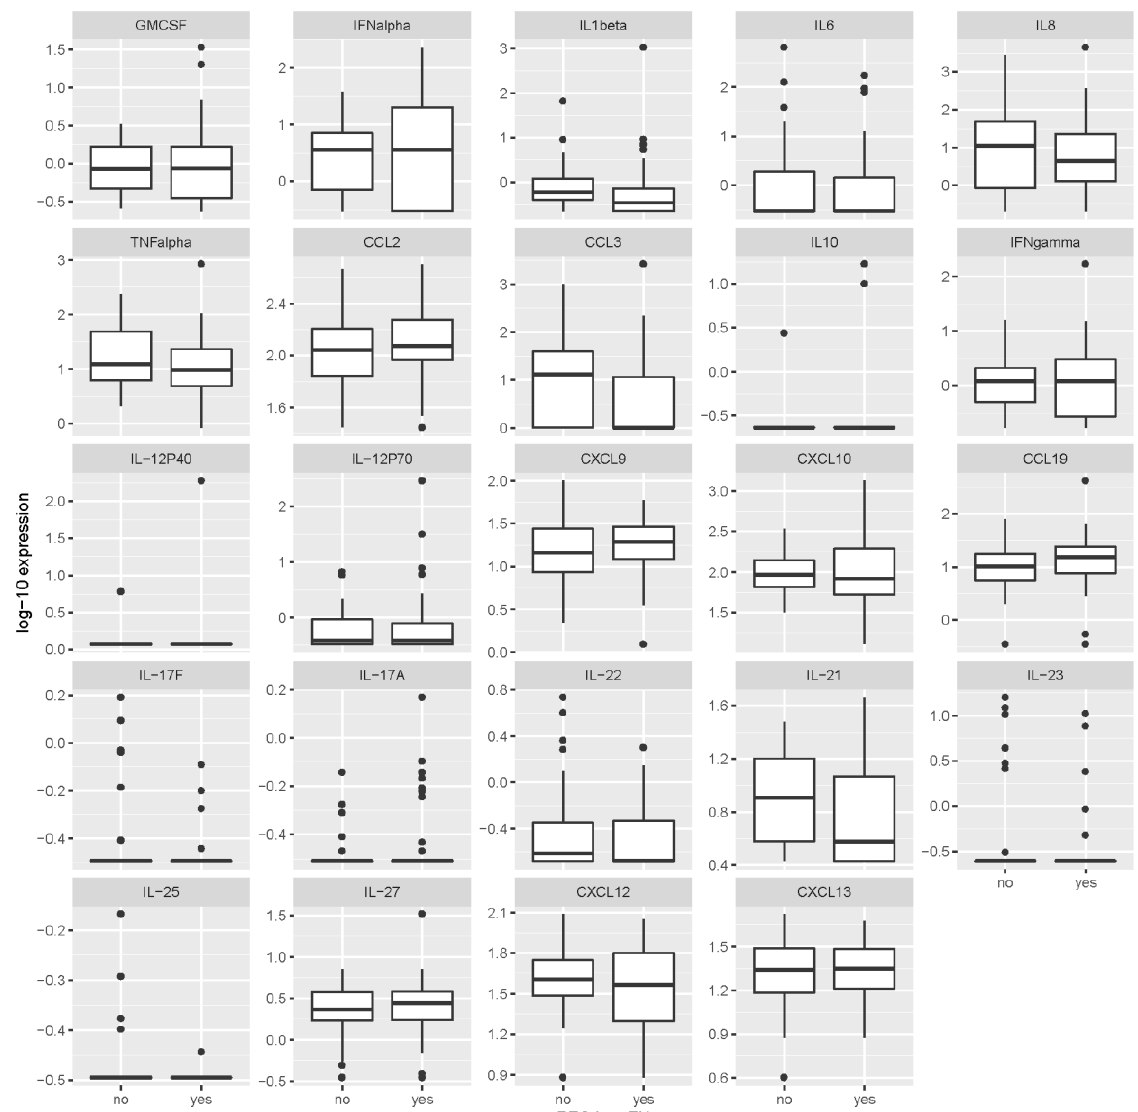
Figure 2. Levels of cytokines / chemokines in serum obtained during the meningoencephalitic phase of tick-borne encephalitis according to the presence or absence of post-encephalytic syndrome at the last follow-up visit (2–7 years after acute illness). Concentrations are in ng / mL for IL-17F, IL-23, IL-25 and IL-27, and in pg / mL for all other inflammatory immune mediators. PES last FU = post-encephalitic syndrome present at last follow-up visit.